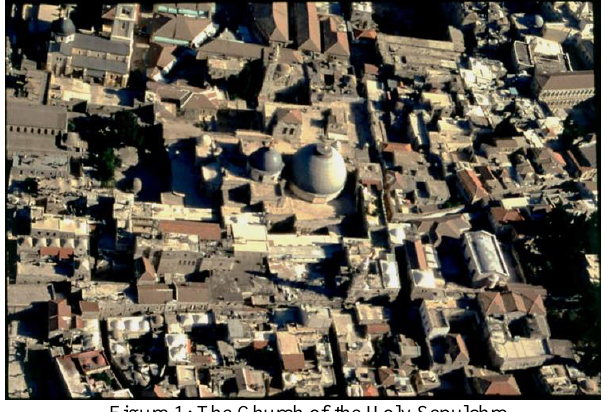
Figure 2: The south façade of the Holy Aedicule in